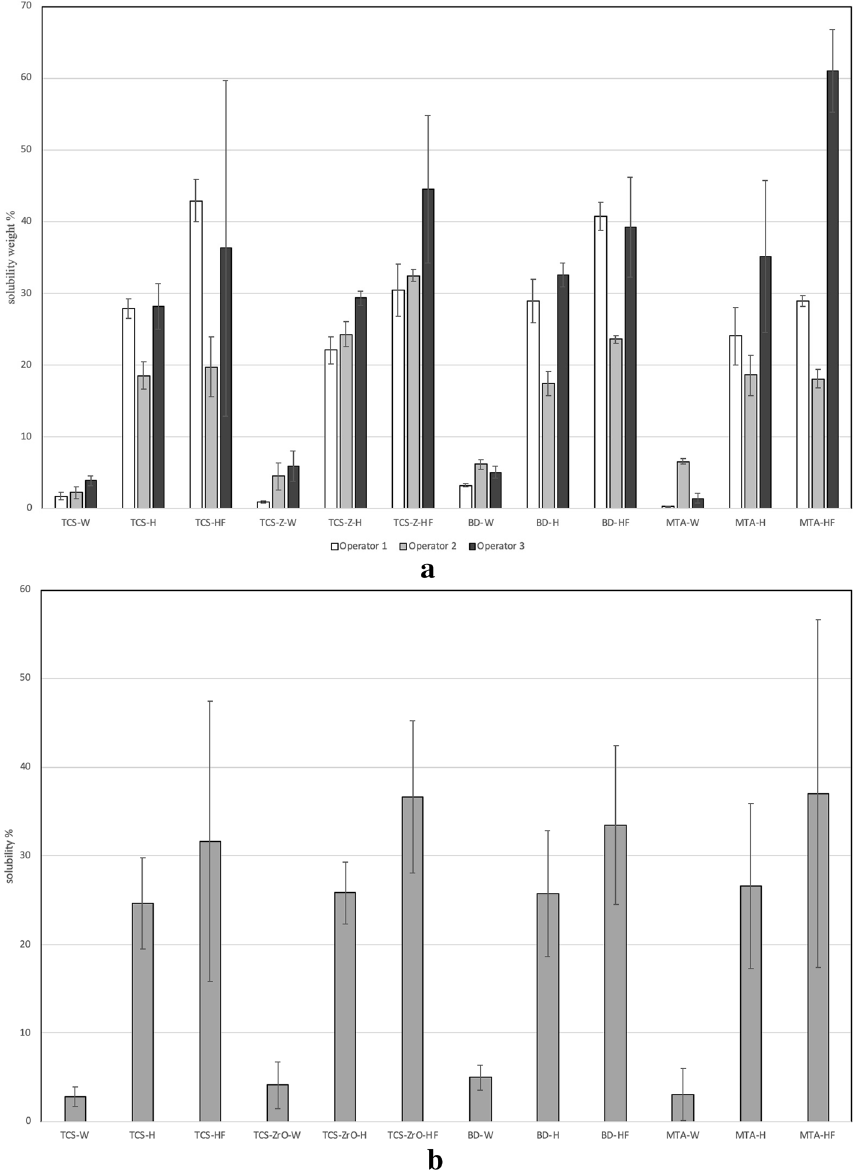
Figure 2. Mean percentage solubility of test materials tested according to ISO 6876; 2012 specifications using water as soaking solution, which is specified in the ISO 6876 method and alternative solutions, which are more clinically relevant. ( a ) Three sets of data of testing undertaken by different operators are shown indicating the dependability on the immersing liquid; ( b ) Pooled data for solubility testing of the materials (±